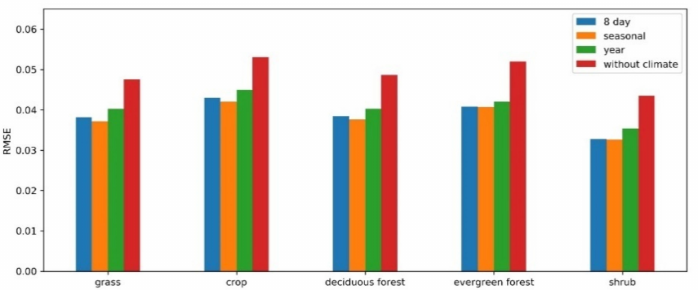
Figure 11. The influence of climate data in the RBFN model for different vegetation